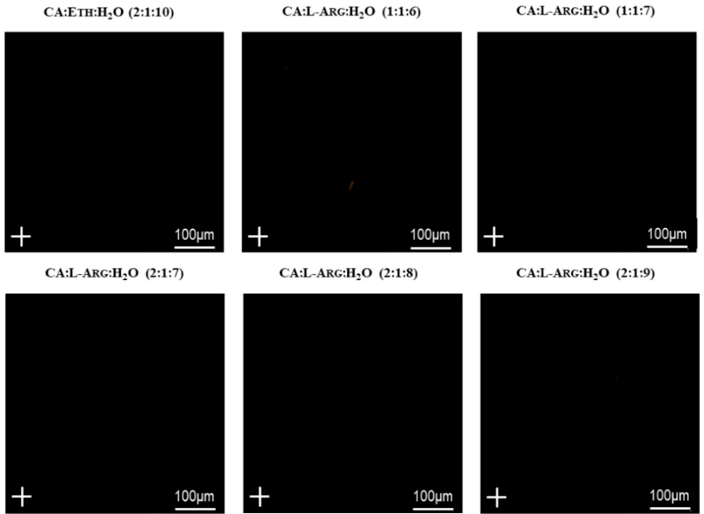
Figure 1. Polarized optical microscopy images of different THEDESs.